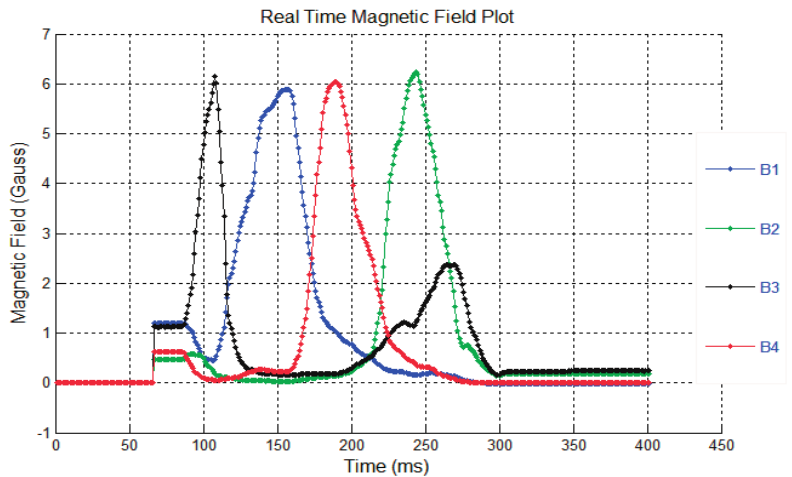
Figure 12. Signal level of the sensors system in